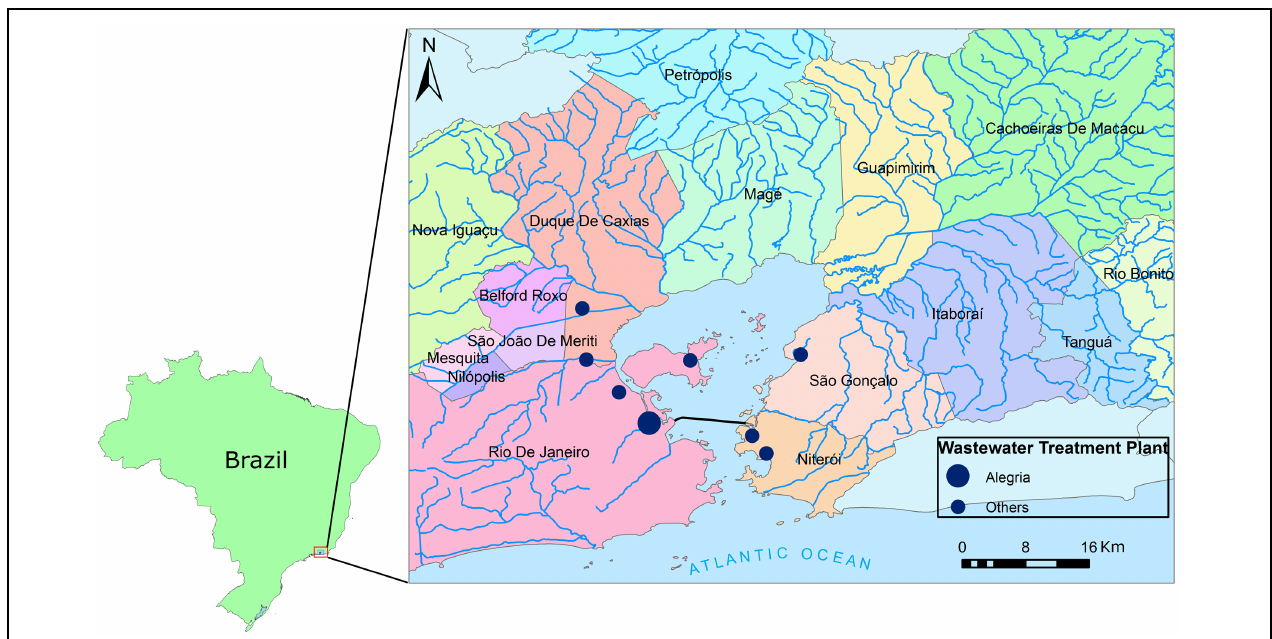
FIGURE 2 | Location of Guanabara Bay, Southeastern Brazil. The cities around the bay and the rivers that form the bay’s drainage area are shown, as well as the location of sewage wastewater treatment plants (WWTPs) (WWTP location obtained from Comitê de Bacia da Baía de Guanabara, SIG-RHGB, http://www . comitebaiadeguanabara . org .